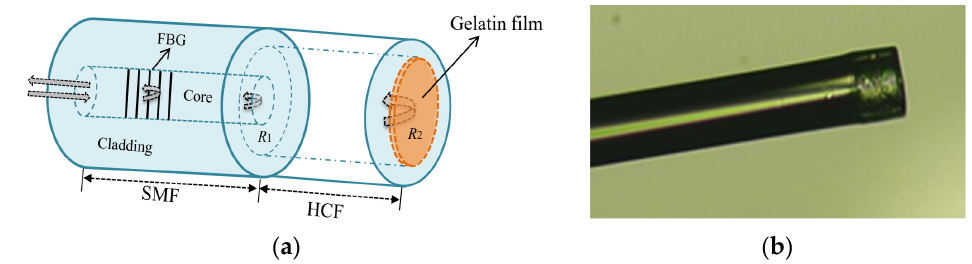
Figure 1. ( a ) Schematic diagram and ( b ) image of the proposed FPI humidity probe.